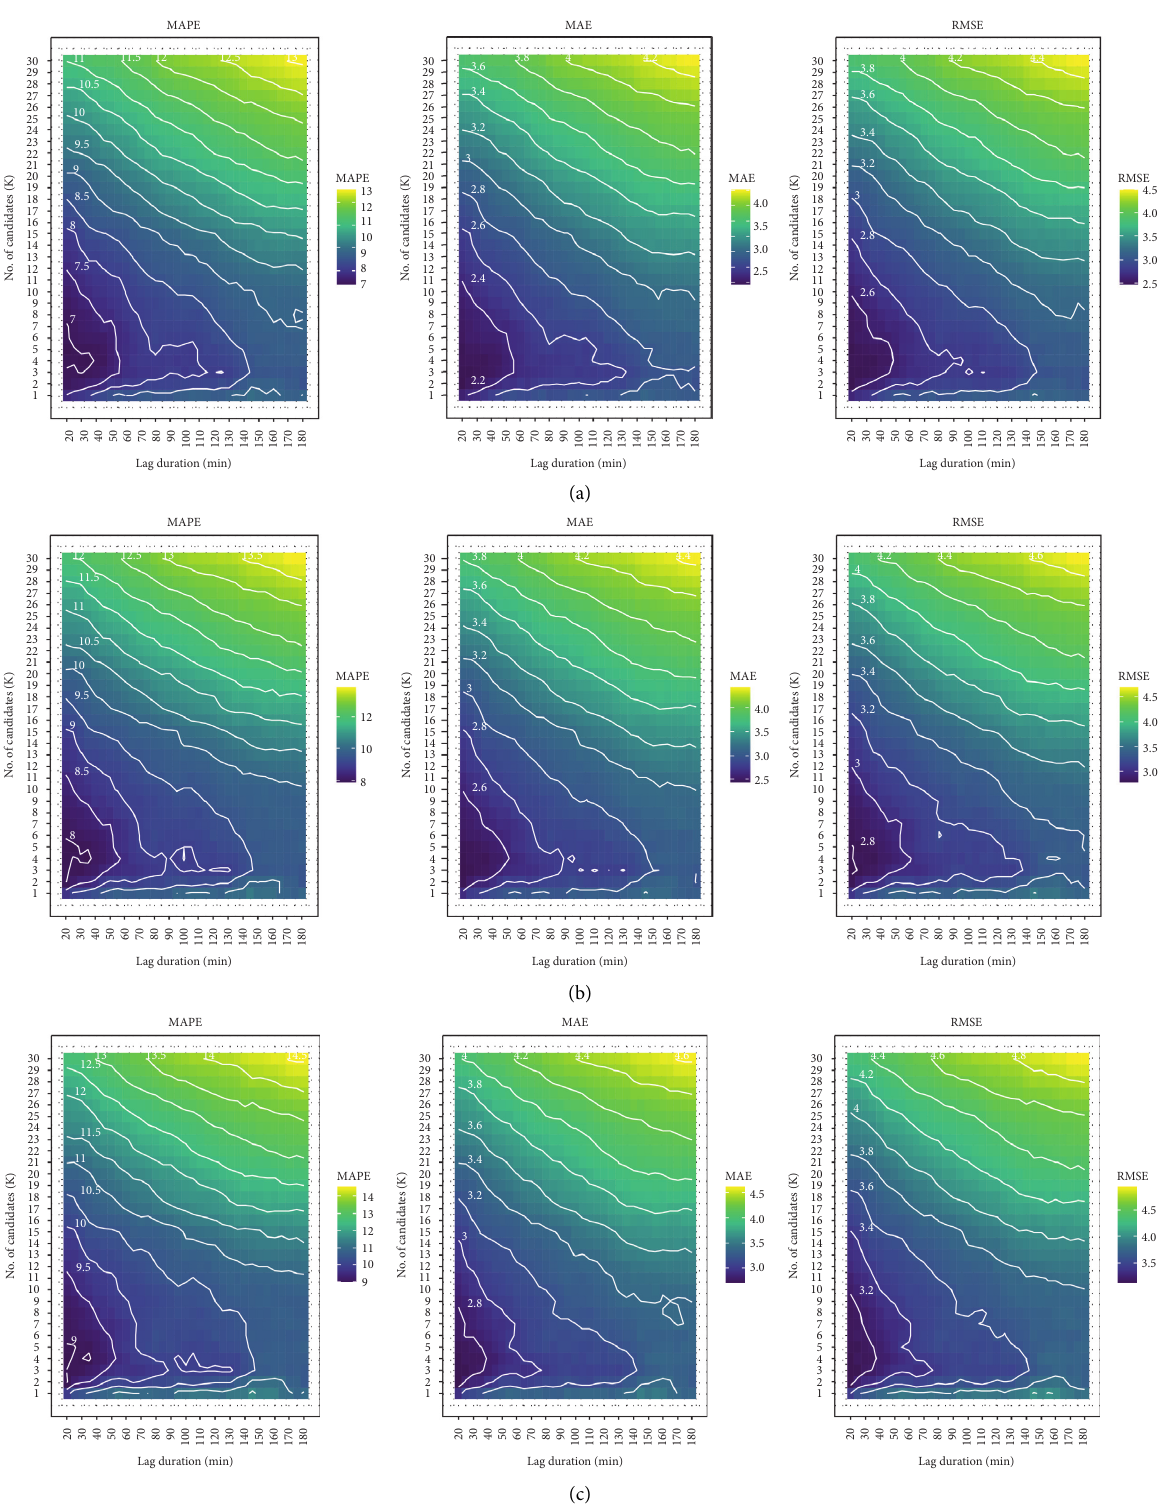
Figure 5: Impact of lag duration and number of candidates on prediction error. (a) Forecast duration:1 hour. (b) Forecast duration: 2 hours. (c) Forecast duration: 3